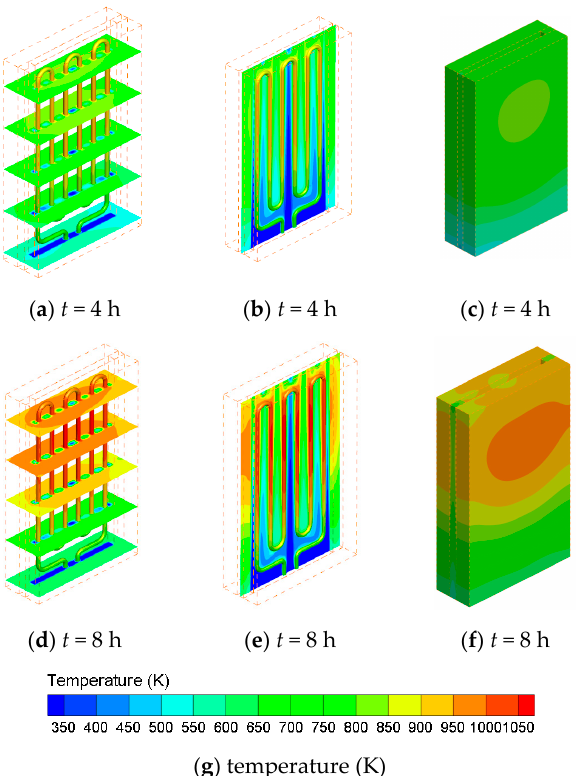
Figure 5. The temperature contours of the cross-sections of the bricks with different height ( a , d ), the middle cross-section of the flow channel ( b , e ), the surface of the electrical heating element ( a–d ), the outer surfaces of bricks ( c , f ) at different charging time ( t = 4 h and 8 h), and the temperature scale ( g ).